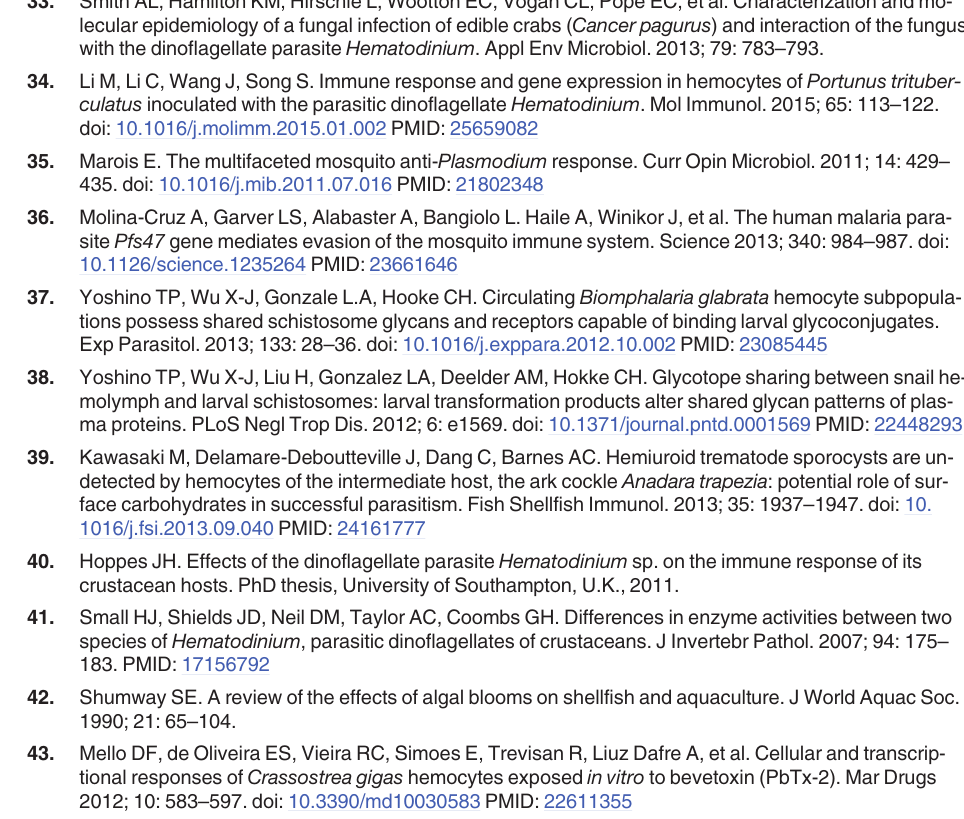
PLOS Pathogens | DOI:10.1371/journal.ppat.1004724 May 7,